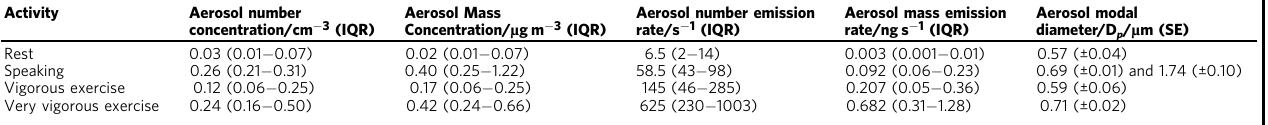
Table 2 Summary of aerosol concentration, emission rate and size distribution data. Activity